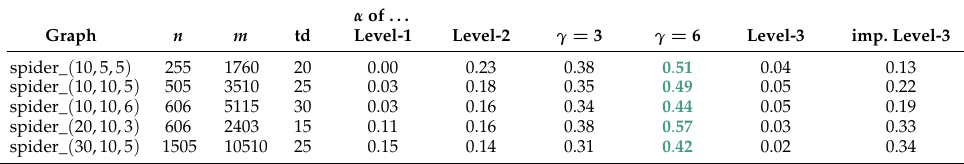
Table 5. Same as Table 4, but on spider-graphs rather than